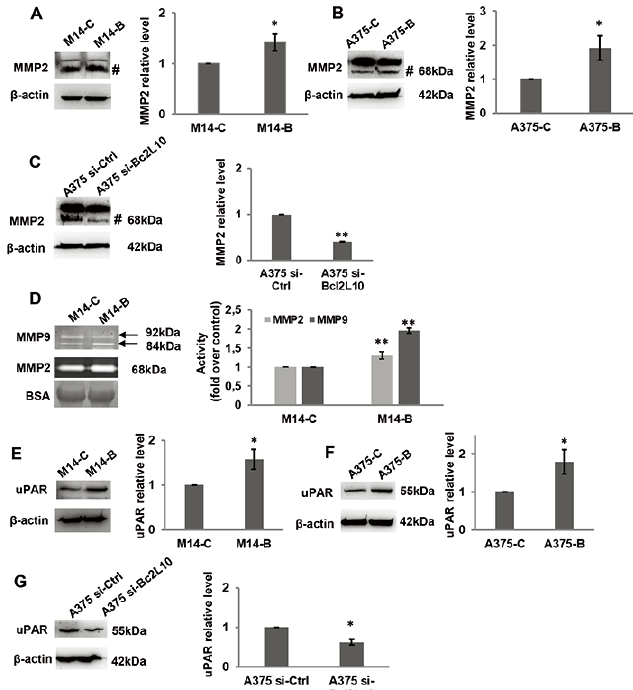
Figure 4. Bcl2L10 promotes metalloproteinases activities and increases uPAR level. (A–C) Western blot analysis and relative densitometric analysis of MMP2 protein expression in protein extracts of (A) M14 cells stably overexpressing Bcl2L10 (M14-B) and relative control (M14-C), and in (B) A375 cells transfected with empty (A375-C) or Bcl2L10 (A375-B) expressing vectors, or (C) with pooled oligonucleotide mix against Bcl2L10 (A375 si-Bcl2L10) or scramble target (A375 si-Ctrl). Active form of MMP2, 68 kDa, is indicated ( # ). (D) Gelatinase activity and relative densitometric analysis of metalloproteinases MMP2 and MMP9 enzymatic activity of CM from M14-B and M14-C cells incubated in serum free medium for 24 h. Active form of MMP2, 68 kDa, and pro- and active form of MMP9, 92 kDa and 84 kDa respectively, are indicated. CM were also analyzed by SDS-polyacrylamide gel electrophoresis, which is transferred to nitrocellulose membrane and bovine serum albumin signal (BSA) was visualized using ponceau staining. (A–D) Representative images of three independent experiments with similar results are shown. (A–C) β-actin primary antibody was used as loading and transferring control. For densitometric analysis, the relative levels of proteins were expressed in the histograms as fold changes respected to relative control after normalization. Data were expressed as mean ± standard deviation. Statistical analysis was performed applying unpaired two-tailed student’s t test with Welch’s correction. * P < 0.05; ** P < 0.01. BSA: bovine serum albumin